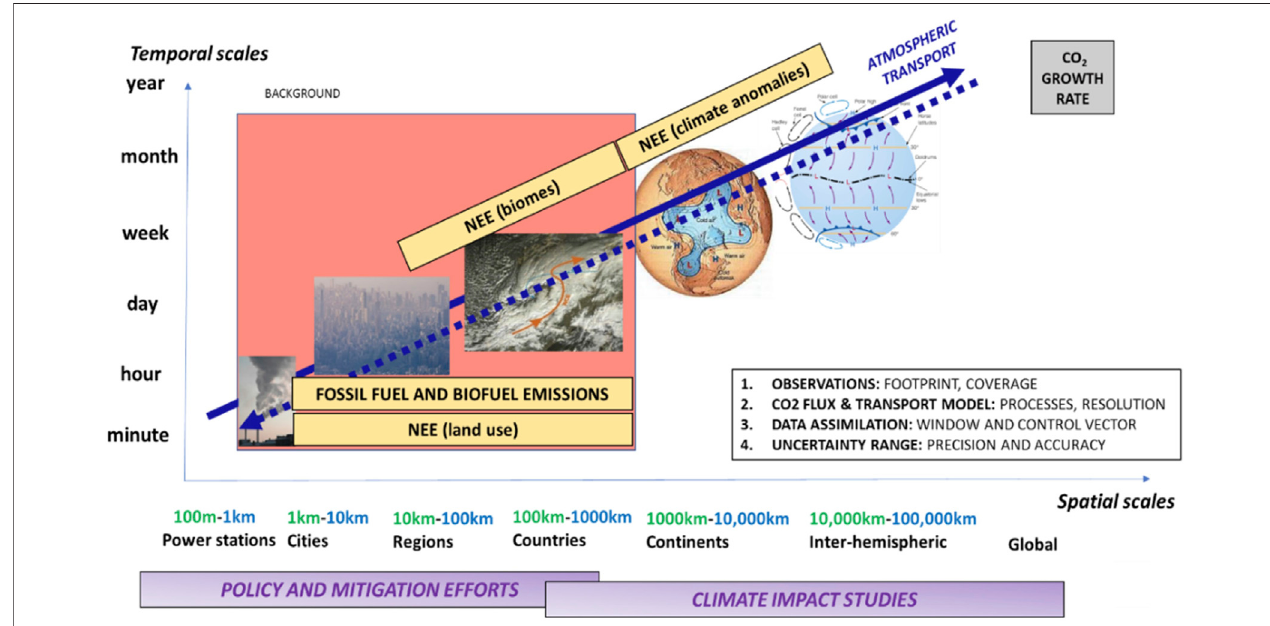
FIGURE 1 | Temporal and spatial scales of CO 2 monitoring from plumes to global CO 2 growth